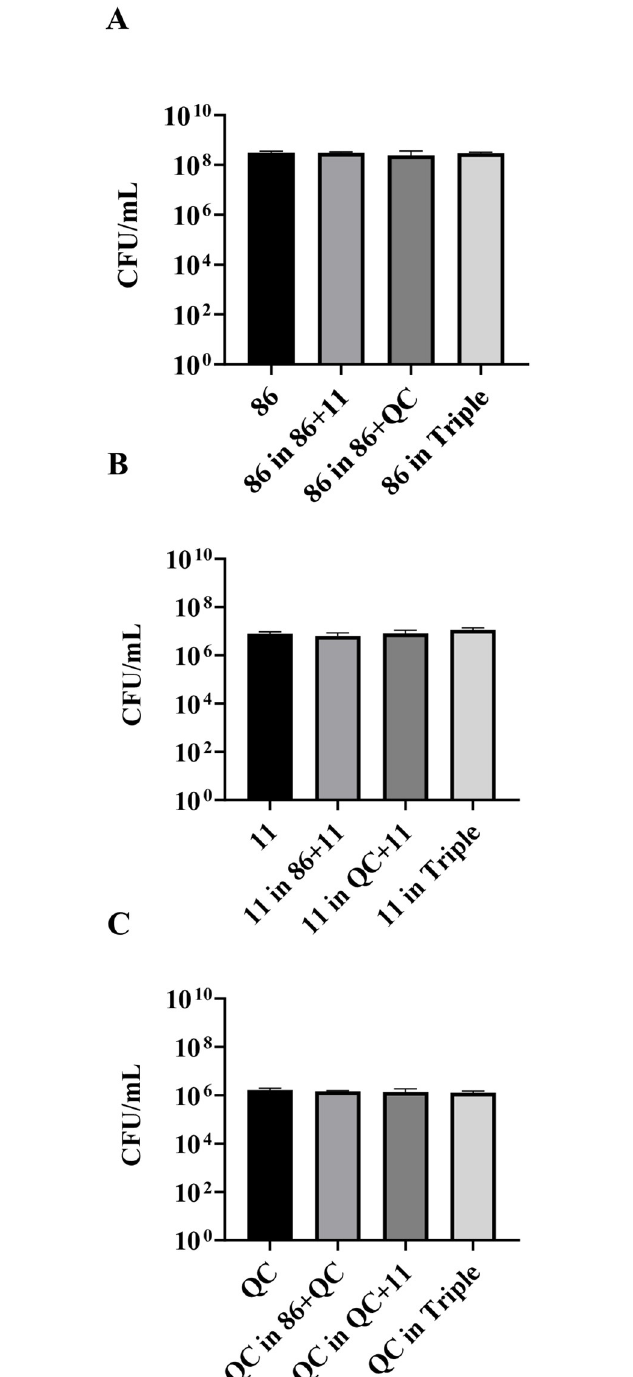
Fig 2. Growth dynamics of dual- and triple-species co-cultures of H . influenzae , S . pneumoniae and M . catarrhalis after 2 h. Growth in mono-, dual- and triple-species co-culture of (A), H . influenzae 86-028NP, (B), S . pneumoniae 11, and (C), M . catarrhalis QC in the planktonic state after 2h of growth are demonstrated as CFU/mL.